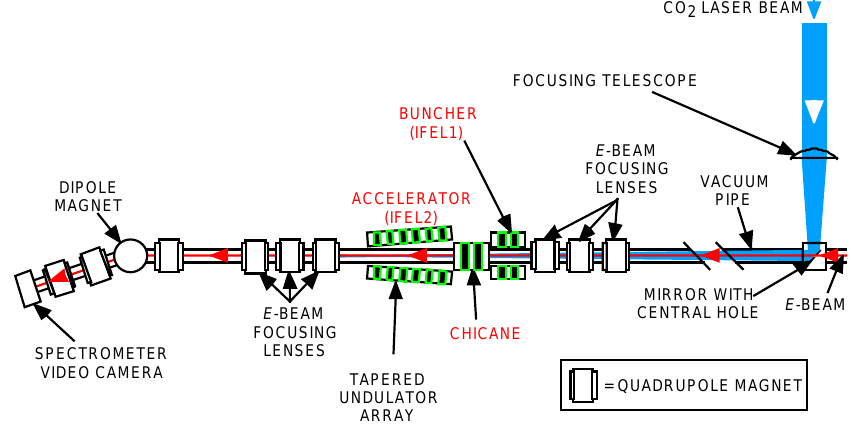
FIG. 9. (Color) Schematic layout for the STELLA-II